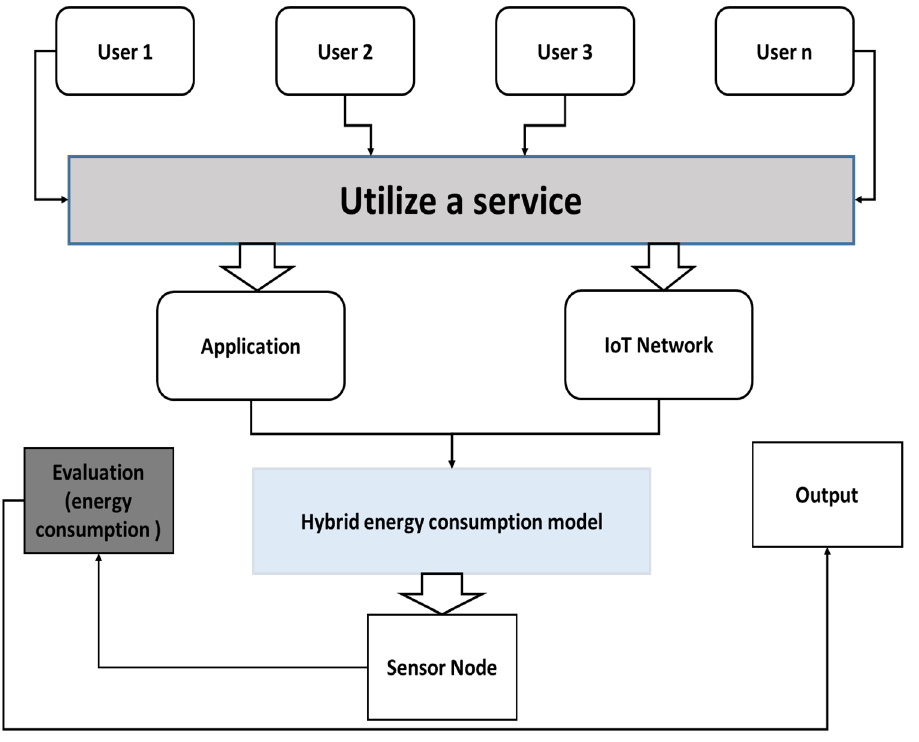
Figure 6. Sleep Time optimization in WBANs for energy efficiency.